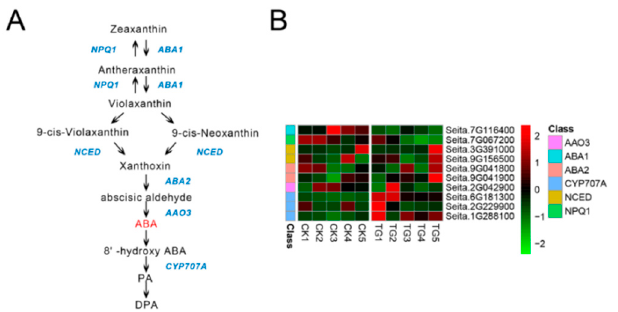
Figure 9. Abscisic acid biosynthetic pathway and differentially expressed genes. ( A ) Abscisic acid biosynthetic pathway. ( B ) Heatmap of differentially expressed genes related to this pathway. The FPKM values of the genes were normalized by Pheatmap package in R language before the heatmap was drawn. In the color legend on the right side of the heatmap, the color labels of each gene correspond to the bar graph on the left side of the heatmap. The experiment was repeated at least three times and the results were similar. The heatmap data are the average of the repeated FPKM